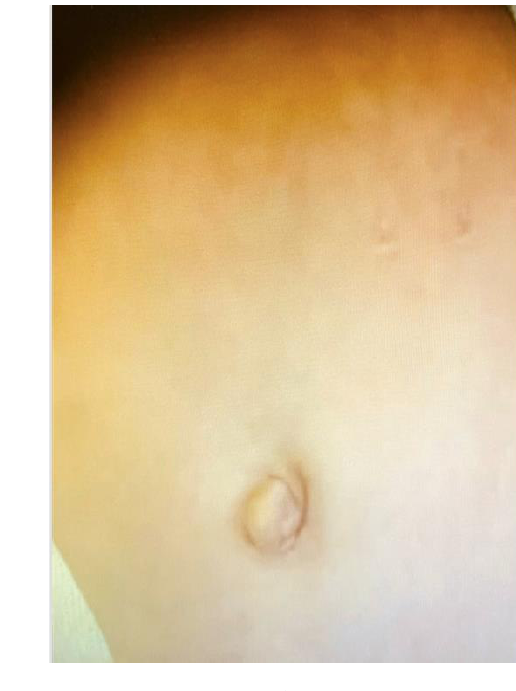
6 of 9 Figure 5. Intraoperative image: positioning of seromuscular thread within the stomach ’s greater curvature and the anterior abdominal muscle wall. 3.3. Outcomes No intraoperative complications were reported. Post-operatively patients were fed on day 3 (min 2 – max 5 days), the main delay was related to the patient being found to have an ileal duplication causing rectal bleeding and requiring a second surgical proce-